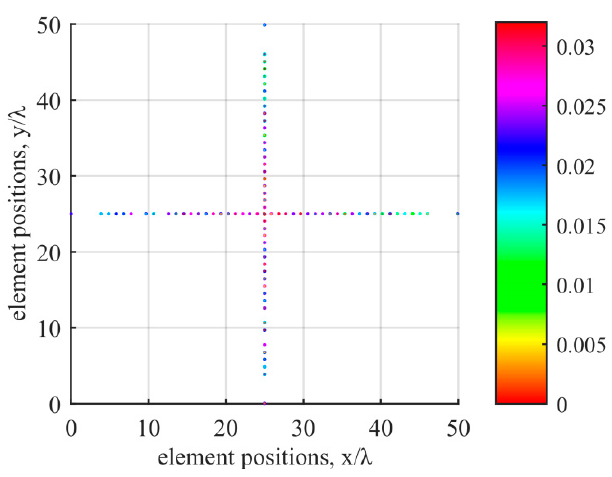
( d ) Figure 8. The transmitting BPs . ( a ) δ = 0, transmitting frequency = 300 kHz; ( b ) δ = 0.083, transmitting frequency = 300 kHz; ( c ) δ = 0, transmitting frequency = 205 kHz; ( d ) δ = 0.083, transmitting frequency = 205 kHz. The positions and weight values of the optimized active sensors at 300 kHz in the far-field are